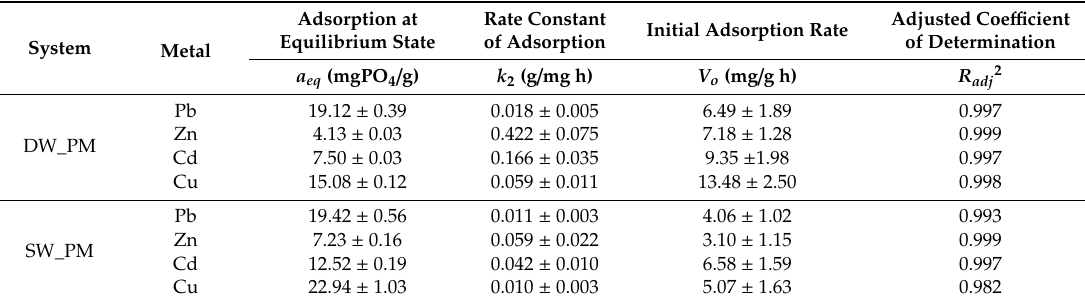
Table 2. Estimated pseudo-second-order kinetic model parameters for metals adsorption by alginate matrices cross-linked with Fe 3 + ions. DW_PM—deionized water enriched with phosphate and metal ions, SW_PM—e ffl uent from a sludge enriched with phosphate and metal ions.